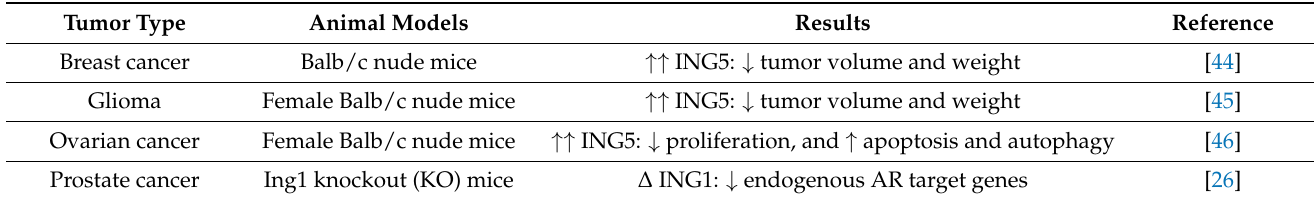
Table 3. Role of INGs in cellular senescence based on animal studies ( ∆ : knock-down, deletion). Tumor